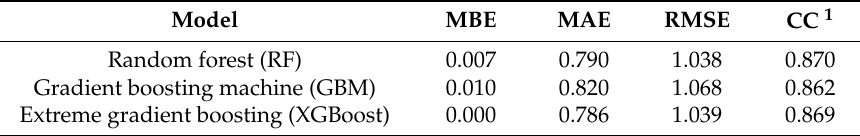
Table 2. Accuracy comparison of the three machine-learning (ML)